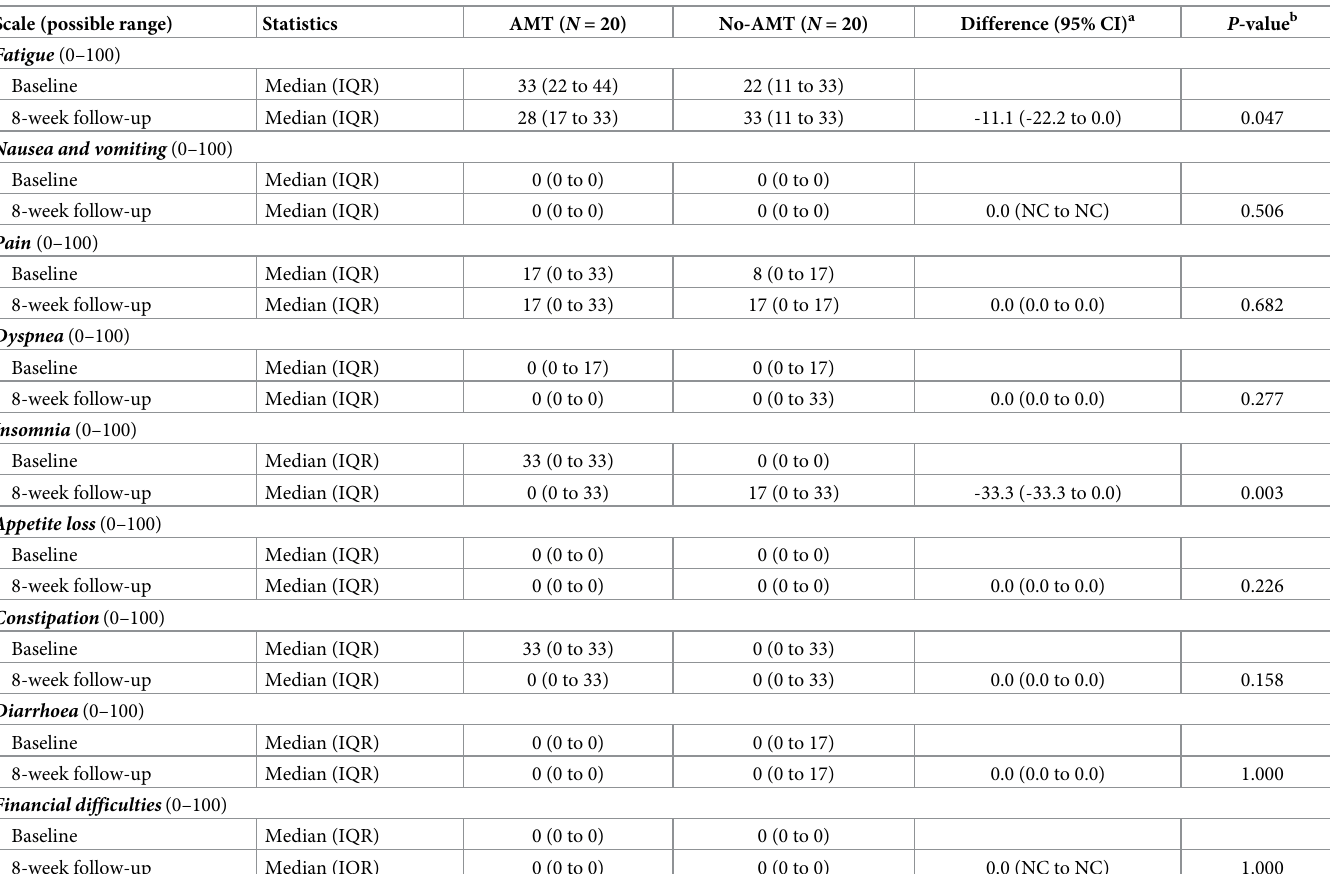
Table 3. Analyses of EORTC QLQ-C30 symptom scales.